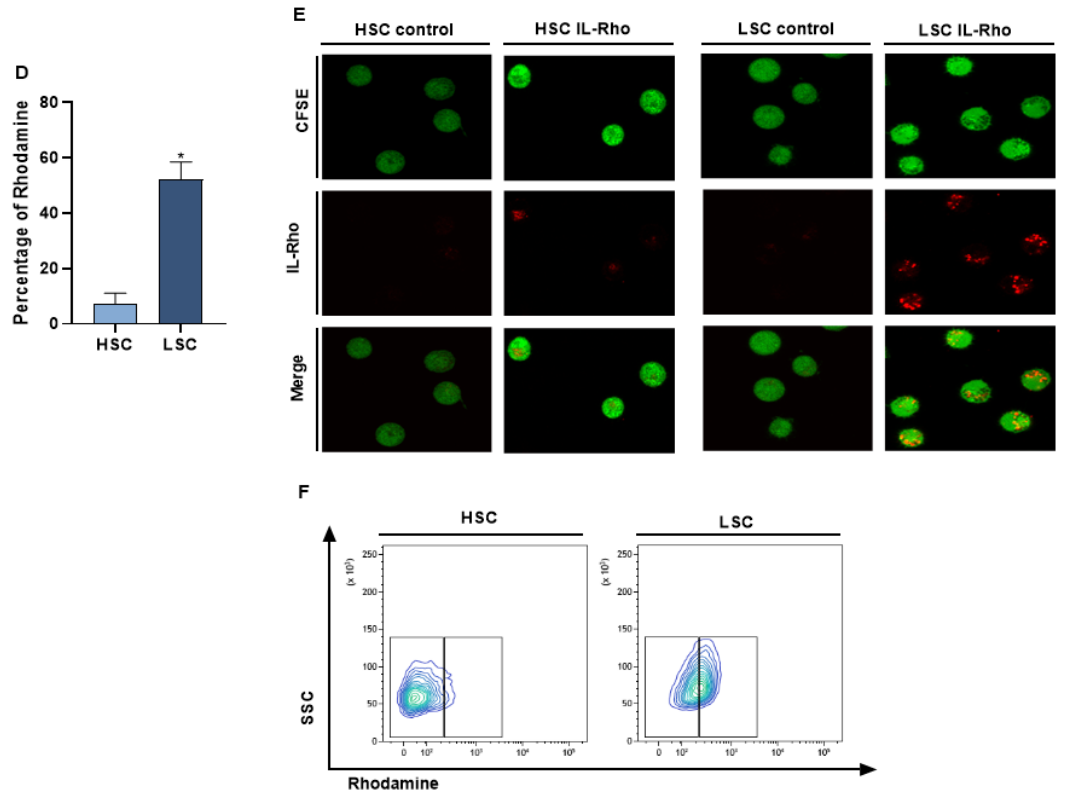
Figure 2. Selectivity assay in CD26+ and CD26 − cells. ( A ) represent the percentage of Rhodamine in CD26+ and CD26 − cells that were acquired after 4 h of the treatment by IL-Rho. Each treated cell line was compared with untreated cells as control. As is clear in ( B ) IL-Rho is not detectable in CD26 − cells while the presence of IL-Rho in CD26+ cells ( C ) is visible (63 × magnification). Also, percentage of Rhodamine was measured by flow cytometry in sorted newly diagnosed CML sample based on CD45dim/CD34+/CD38 − /CD26 − (HSCs) andCD45dim/CD34+/CD38 − /CD26+ (LSCs) expression ( D ). As is displayed in ( D ) IL-Rho remarkably targeted CML LSCs, and this result was confirmed by confocal analysis as shown in ( E ) (63 × magnification). Flow cytometry graph of one sorted newly diagnosed CML patient treated with IL-Rho is depicted in ( F ). (* p < 0.05, and ** p < 0.01).